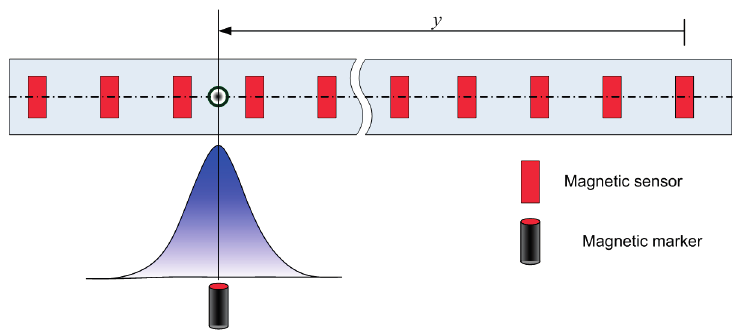
Figure 2. Simple schematic of multi-sensor array in the MSR.